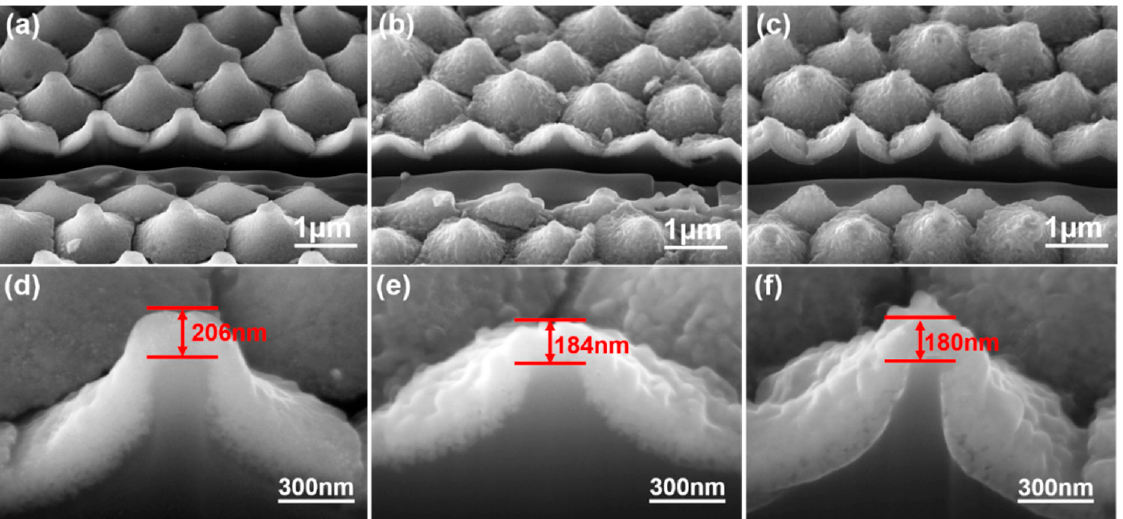
Figure 4. Low-magnification cross-sectional SEM images of the ZnO seed layer on Al sacrificial layers of different thicknesses: ( a ) 120, ( b ), 420, and ( c ) 720 nm. High-magnification cross-sectional SEM images of the ZnO seed layer on Al sacrificial layers of different thicknesses: ( d ) 120, ( e ) 420, and ( f ) 720 nm.